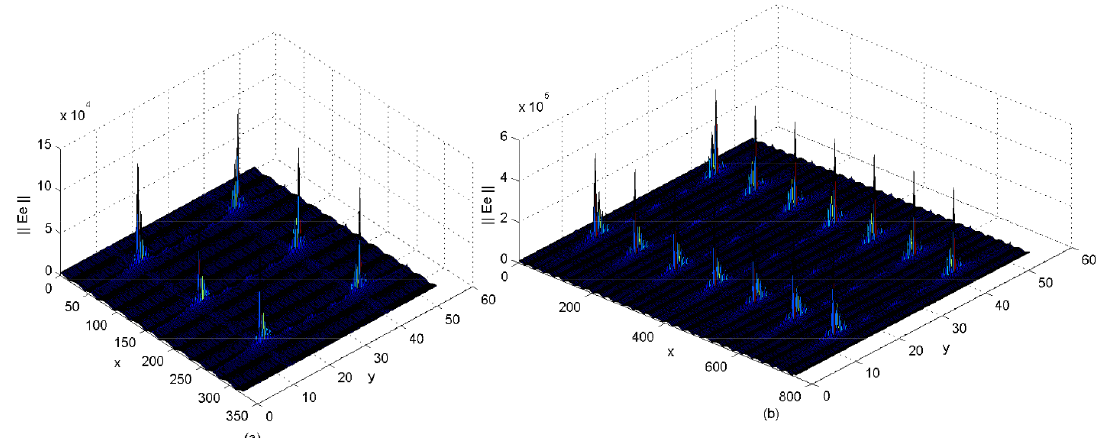
Figure 12. Electric field of the almost periodic array (half-wave dipoles) defined by the waveguide’s aperture, described by the basis functions (guide’s modes) using ( a ) three cells or ( b ) seven cells at the operating frequency (f) of 5.4 GHz. The physical parameters were: α 0 = 0 rad m − 1 , β 0 = 0 rad m − 1 , w = 1 mm, δ = 0.75 mm ( w (cid:28) λ 0 , δ (cid:28) λ 0 ) , d x = 108 mm, d y = 108 mm, L = λ 0 h = 1.25 mm, and (cid:101) = (cid:101) r = 1 (air) (see [1] for a